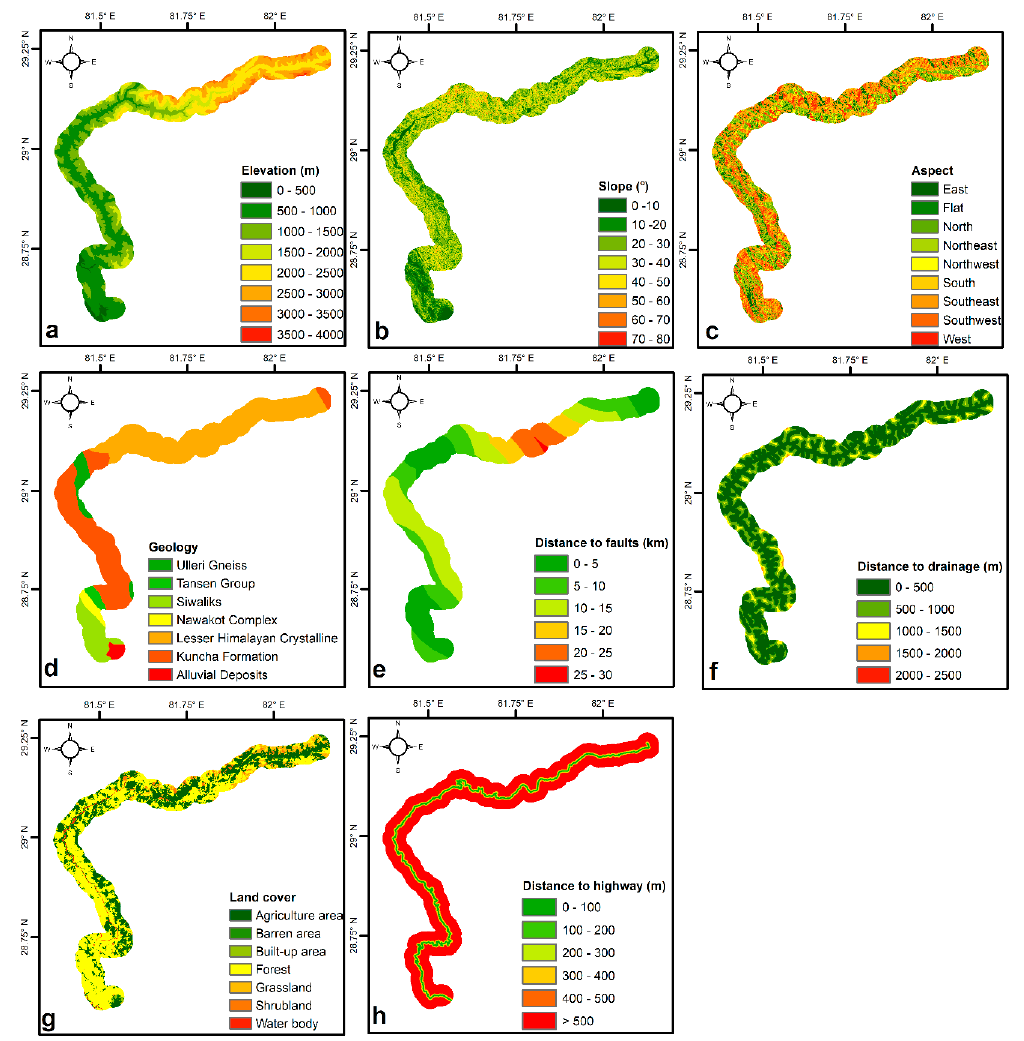
Figure 3. Landslide explanatory variables. Topographical: ( a ) elevation; ( b ) slope; ( c ) aspect; geological: ( d ) geology; ( e ) distance to faults; hydrological: ( f ) distance to drainage and anthropogenic: ( g ) land cover; ( h ) distance to highway.